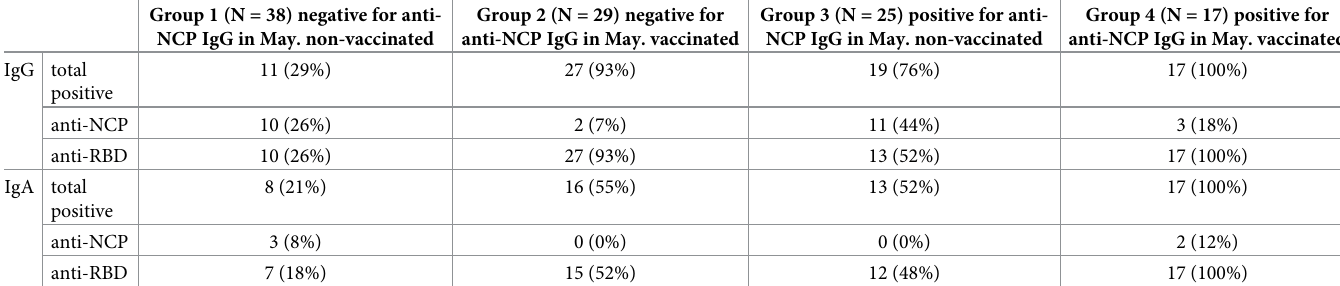
The number of positive individuals and respective fraction (%) are presented. Antibodies were identified in blood samples after separation of blood sera by clotting and centrifugation. Microblot-Array testing was applied to qualify IgG level as positive or negative according to the cut-off given by the manufacturer, NCP–nucleocapsid protein, RBD–receptor binding